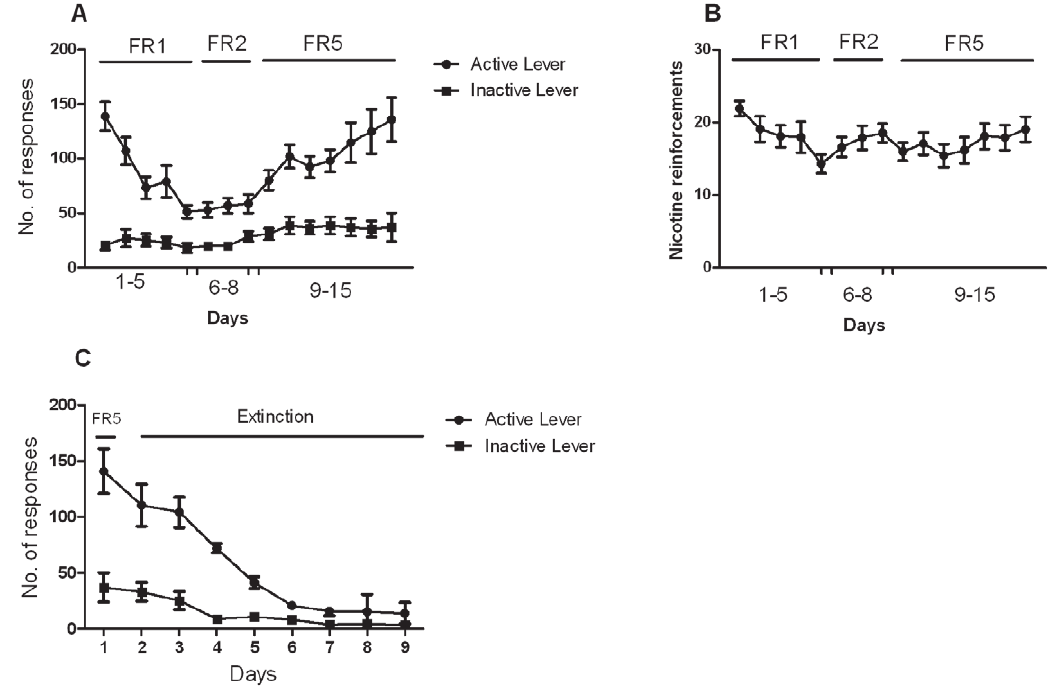
Figure 1. Pattern of respondinng during acquisition and extinction phases. A. Acquisition of nicotine self-administration (30 m g/kg/ infusion). The total number of active ( N ) and inactive( & ) lever presses (means 6 SEM) received in each session (during time in and time out periods) under the different schedules of reinforcement (FR- 1, FR-2, FR-5,). B. Number of nicotine infusions (means 6 SEM) earned during acquisition phase in the same group of animals represented as fig. 1A. C. The number of active ( N ) and inactive( & ) lever presses (means 6 SEM) received in each extinction session in the same group of animals represented in figures 1A & 1B.